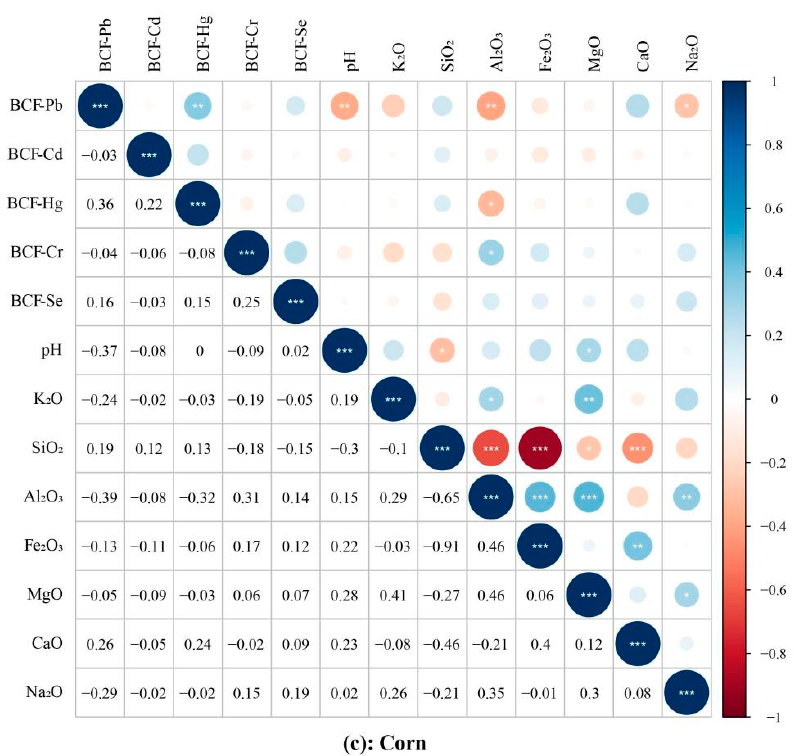
Figure 4. Pearson correlation between transfer factors of HMs and the physicochemical properties of soil for different types of crops (*** denotes significant correlation at p < 0.001; ** denotes significant correlation at p < 0.01; and * denotes significant correlation at p < 0.05).